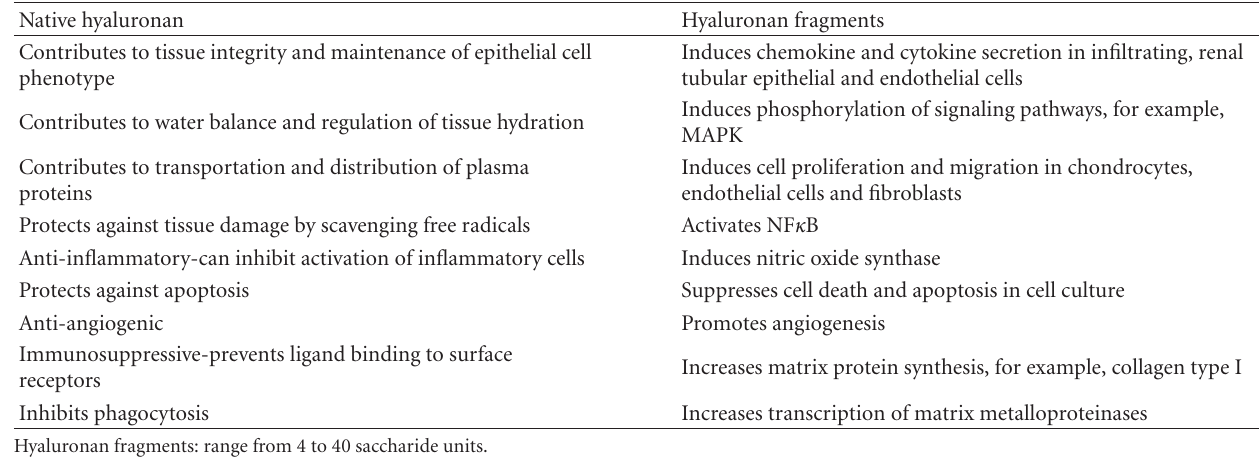
Table 1: Functions of native and depolymerized hyaluronan.